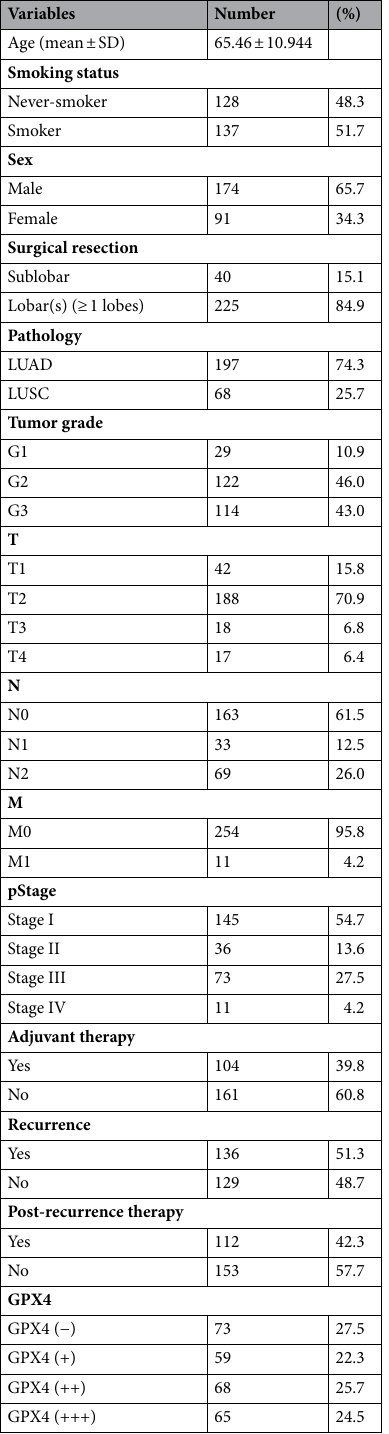
Table 1. Patient characteristics of 265 resected NSCLCs. SD standard deviation, T tumor, N nodes, M metastases, LUAD lung adenocarcinoma, LUSC lung squamous cell carcinoma, G1 well differentiated, G2 moderately differentiated, G3 poorly differentiated, pStage pathological stage, GPX4 glutathione peroxidase 4, GPX4 (−) less than 5% were positive for immunohistochemical (IHC) stain, GPX4 (+) IHC stain